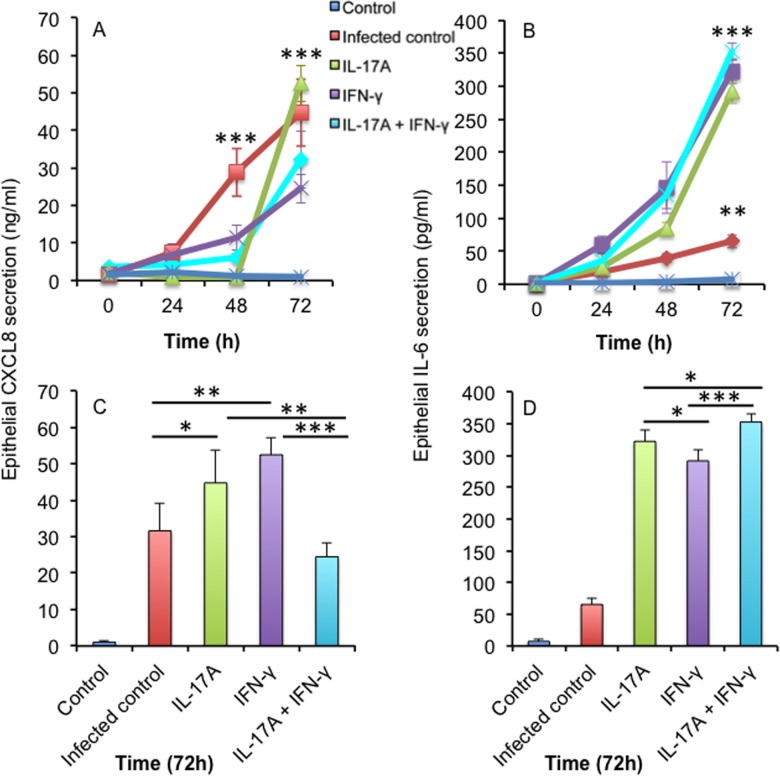
The effect of BCG infection on epithelial cytokine expression.(A) CXCL8 and (B) IL-6 production from epithelial cells stimulated with BCG in combination with IL-17A and/or IFN-γ for 0, 24, 48 and 72 hours, MOI 1:1. The 72 hours time points are in addition represented as bar graphs for (C) CXCL8 and (D) IL-6. The results are depicted as mean ± SD of three experiments. Means were compared with one way ANOVA followed by multiple comparisons test with Tukey’s correction and significance was accepted at *p < 0.05, **p< 0.01, or ***p < 0.001.